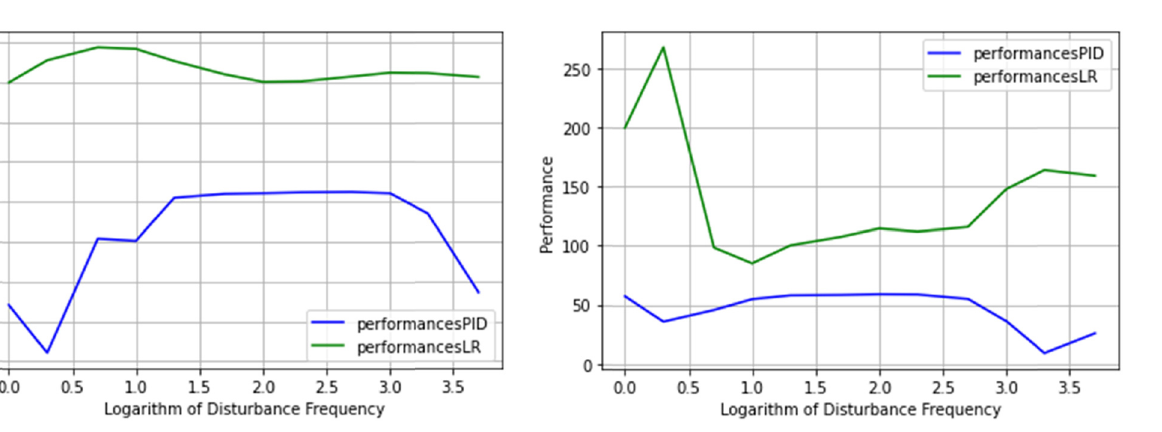
Figure 11: Performances of PID and LR controllers for disturbance magnitude of 3 × 10 − 2 .